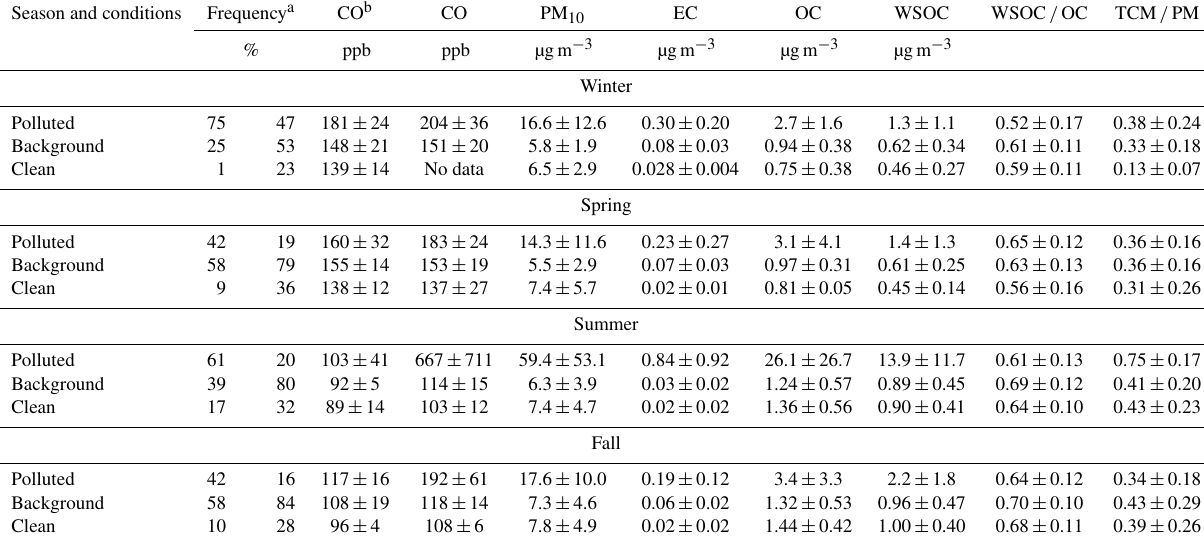
algorithmandtogethercomprise100%,whilecleanperiodswereselectedindependentlybasedonEC(thisstudy)orBC e concentrations(Chietal.,2013)asindicatedinthetext. b COdatafrom September2006toDecember2011at300matZOTTO(Chietal.,2013).